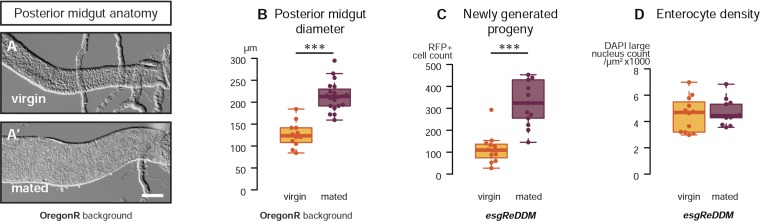
Mating re-sizes the Drosophila gut.The increase in gut size at 3 days after mating is also measurable (A, A′) and significant (B, p < 0.001, t-test) in the OregonR background. The esgReDDM tracing system reveals that mated guts contain more cells generated in the last 7 days if the fly had been mated in that time (C, p < 0.001, t-test) than if it had not. The size increase is not due to stretching of the tissue, as the density of nuclei in the posterior midgut remains the same (D, p = 0.77, t-test). See Table 1 for full genotypes.